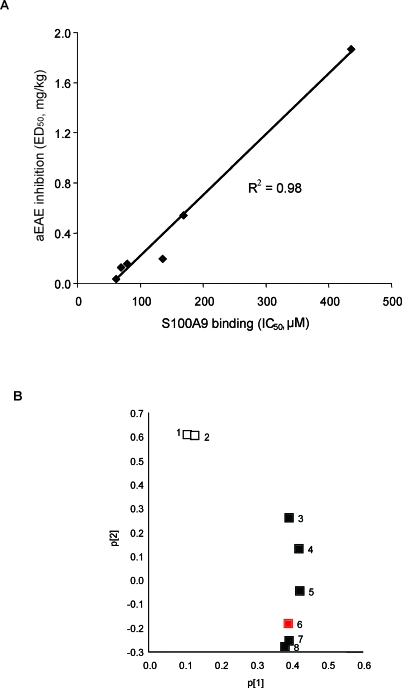
PCA Loading Plot of the Relationship between Q Compound S100A9 or S100A8/A9 Binding Activity and aEAE Inhibition(A) Correlation between the binding strength to S100A9 of the Q compounds (Table S1) and their efficacy in inhibiting aEAE in vivo.(B) Loading plot of the first two principal components (p[1] and p[2]) demonstrating the relationship between S100A9 and S100A8/A9 binding activity and aEAE inhibition. 1: mS100A8/A9 and mRAGE; 2: mS100A8/A9 and mLPS-Trap; 3: mS100A9 and ABR-224649; 4: mS100A9 and mLPS-Trap; 5: mS100A9 and mRAGE/hFc; 6: aEAE; 7: hS100A9 and rhTLR4/MD-2; and 8: hS100A9 and rhRAGE/Fc.